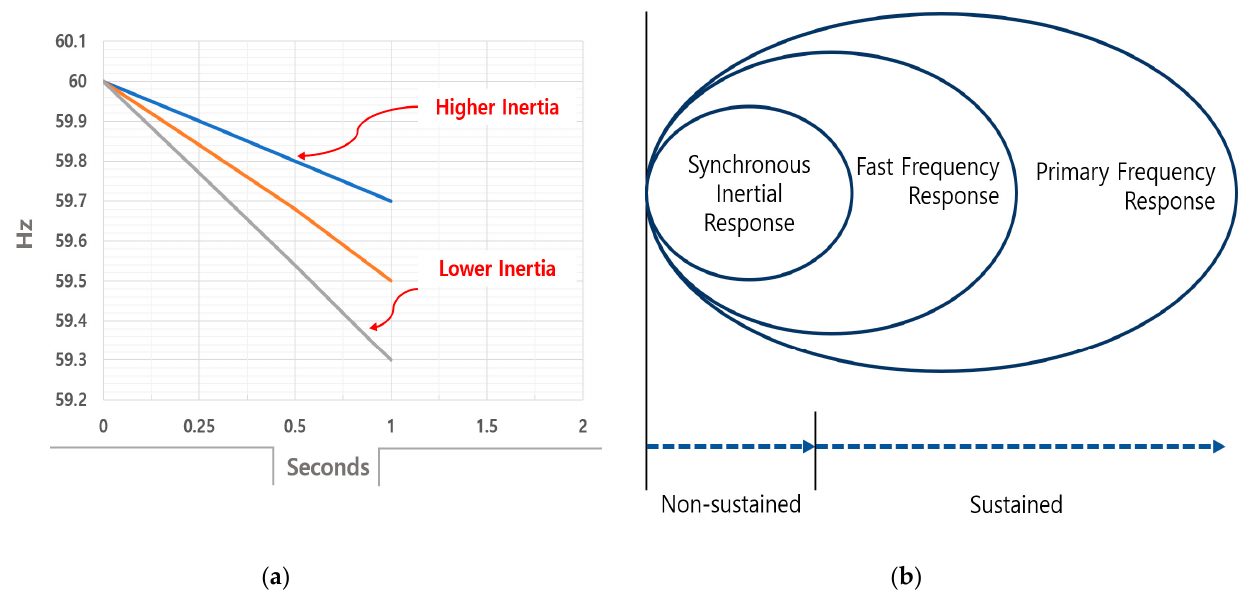
Figure 1. ( a ) Frequency response characteristics according to synchronous inertia change. ( b ) Frequency response contribution of inertia; FFR—fast frequency response; PFR—primary frequency response [6].